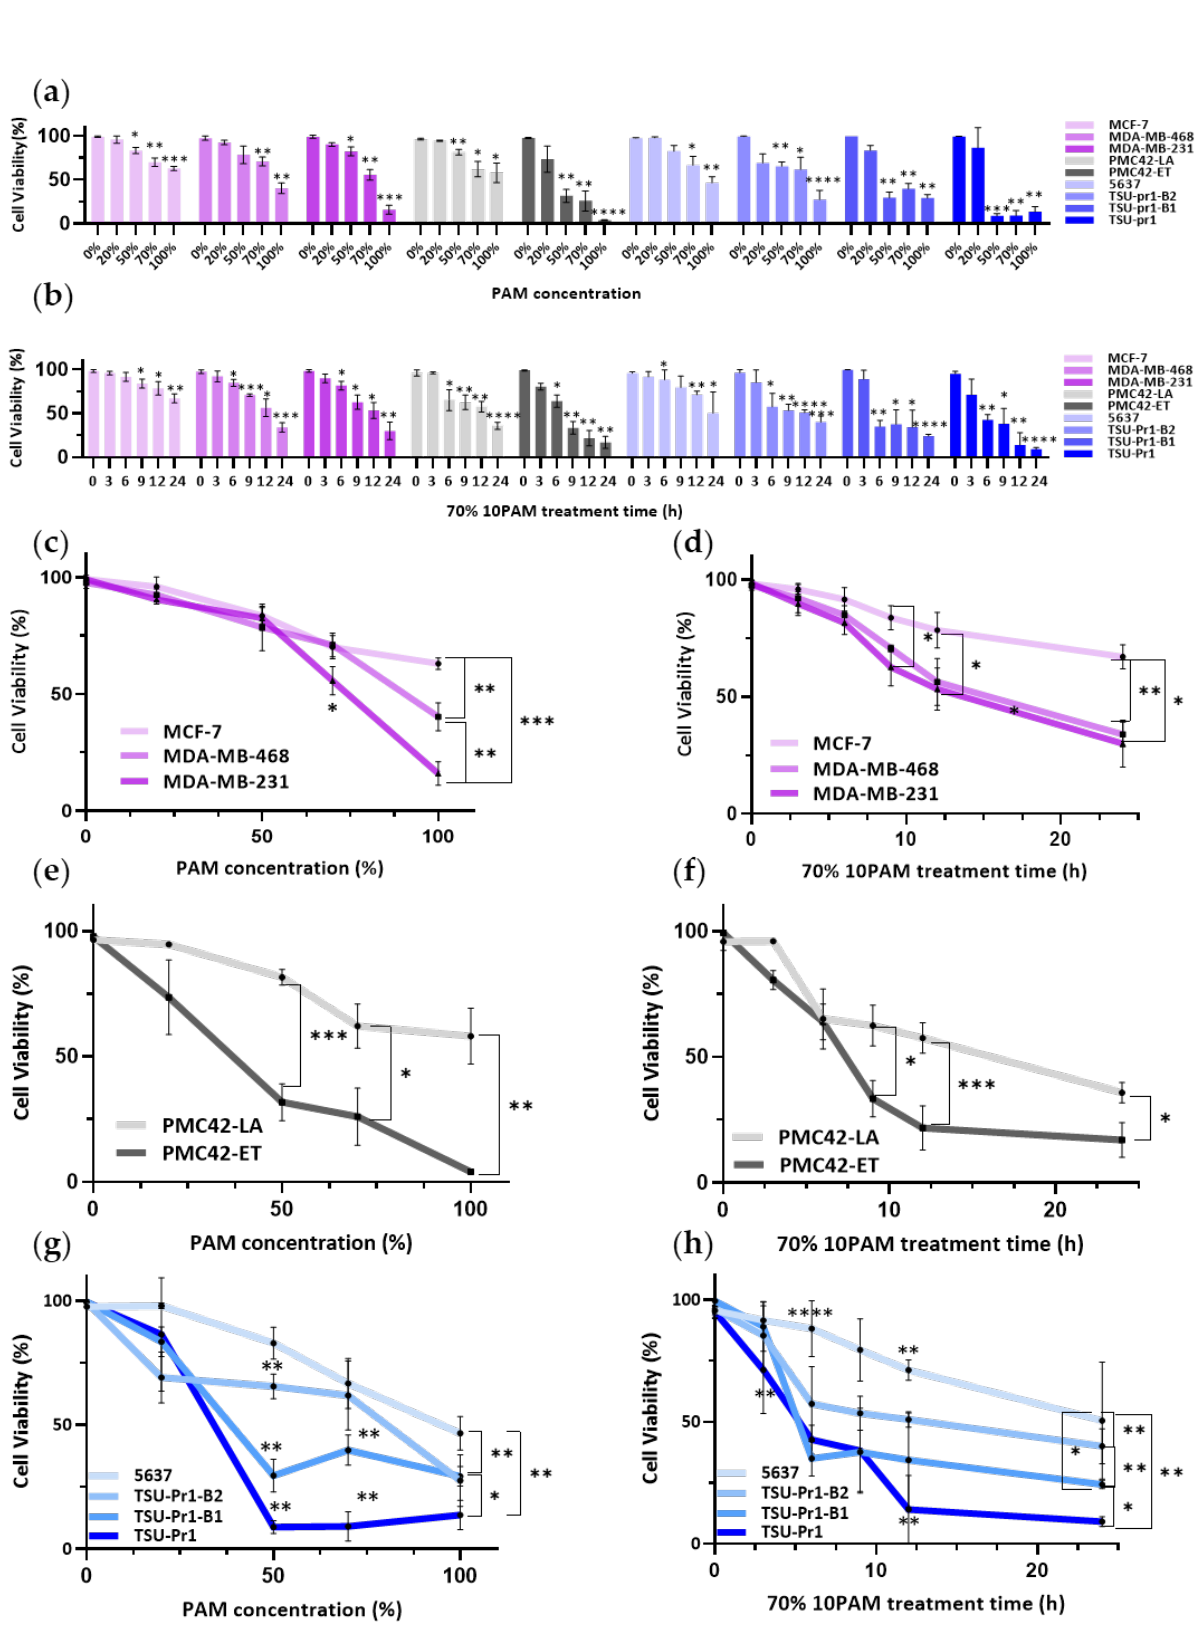
Figure 1. PAM selectively affects mesenchymally-shifted cancer cells. Breast cancer cell lines (MDA-MB-231/MDA-MB- 468/MCF-7; pink) and EMT/MET cell line systems in breast (PMC42-ET/LA; grey) and bladder